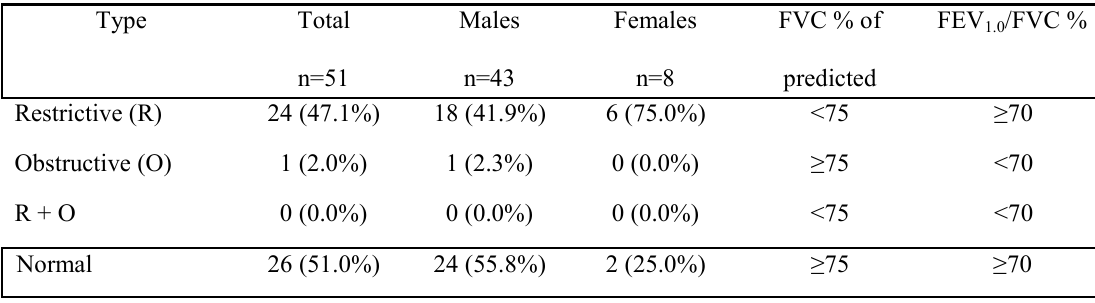
Table 5 – Type of ventilatory impairment among granite